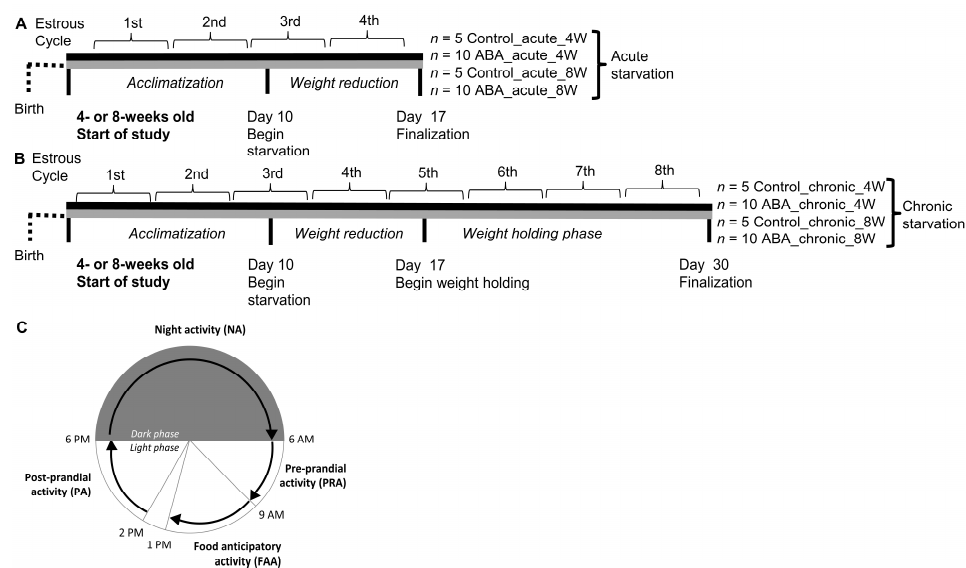
Figure 1. A schematic summary of the ABA model. ( A ) Schematic depicting the experimental study to induce acute starvation in (i) early adolescent (4 weeks old) and (ii) in adolescent (8 weeks old) mice. ( B ) Schematic depicting the experimental study to induce chronic starvation in (i) early adolescent and (ii) adolescent mice. Body weight, running wheel activity and estrous cycle were analyzed daily. The 4-day blocks of estrous cycle are presented in the chronological course of the model. ( C ) To measure the different daily periods of running activity, the experimental structure of cycles of 24 h with the following phases was used: food-anticipatory activity (FAA, 4 h, from 9 a.m. to 1 p.m.), post-prandial activity (PA, 4 h, from 2 p.m. to 6 p.m.), night activity (NA, 12 h, 6 p.m. to 6 a.m.